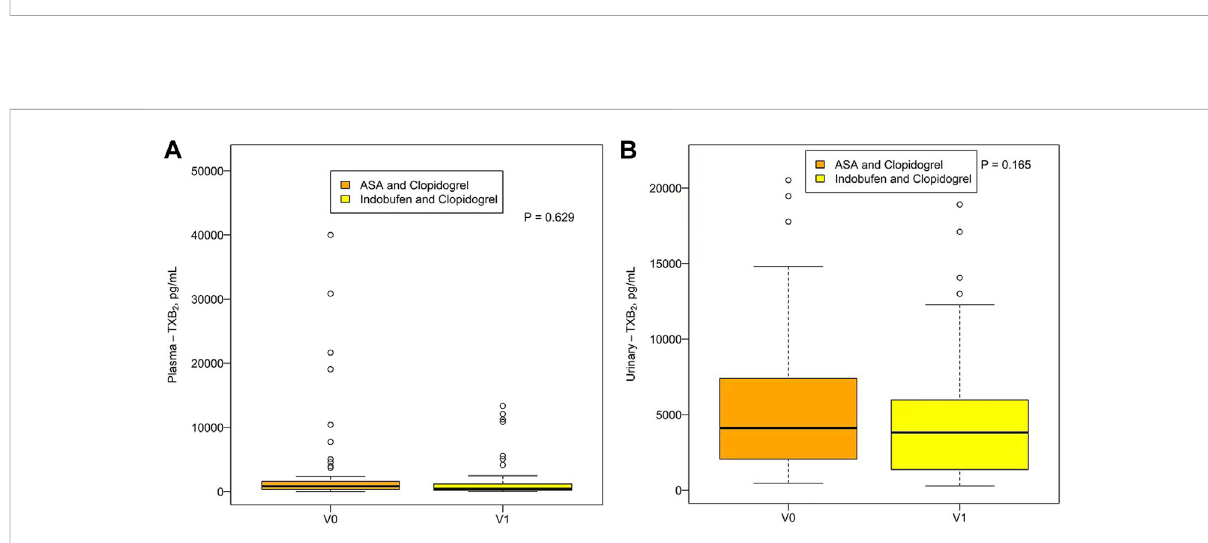
FIGURE 4 Plasma (A) andurinary (B) TXB 2 concentrationsintheaspirin+clopidogrelgroup(V0)andtheindobufen+clopidogrelgroup(V1).ASA=aspirin; TXB 2 = thromboxane B 2